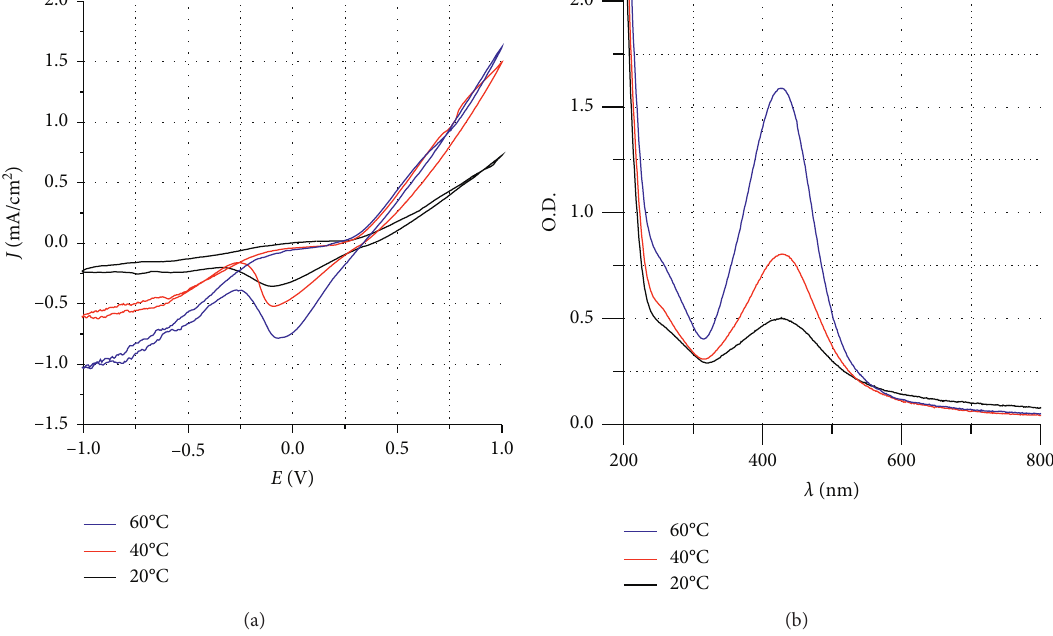
Figure 5: Cyclic voltamperograms (a) and spectral dependences of optical absorption (b) of AgNPs, synthesized ultrasonically in an aqueous solution of RL (2g/L) at the temperature of t � 20, 40, and 60 ° C and the process duration of 20